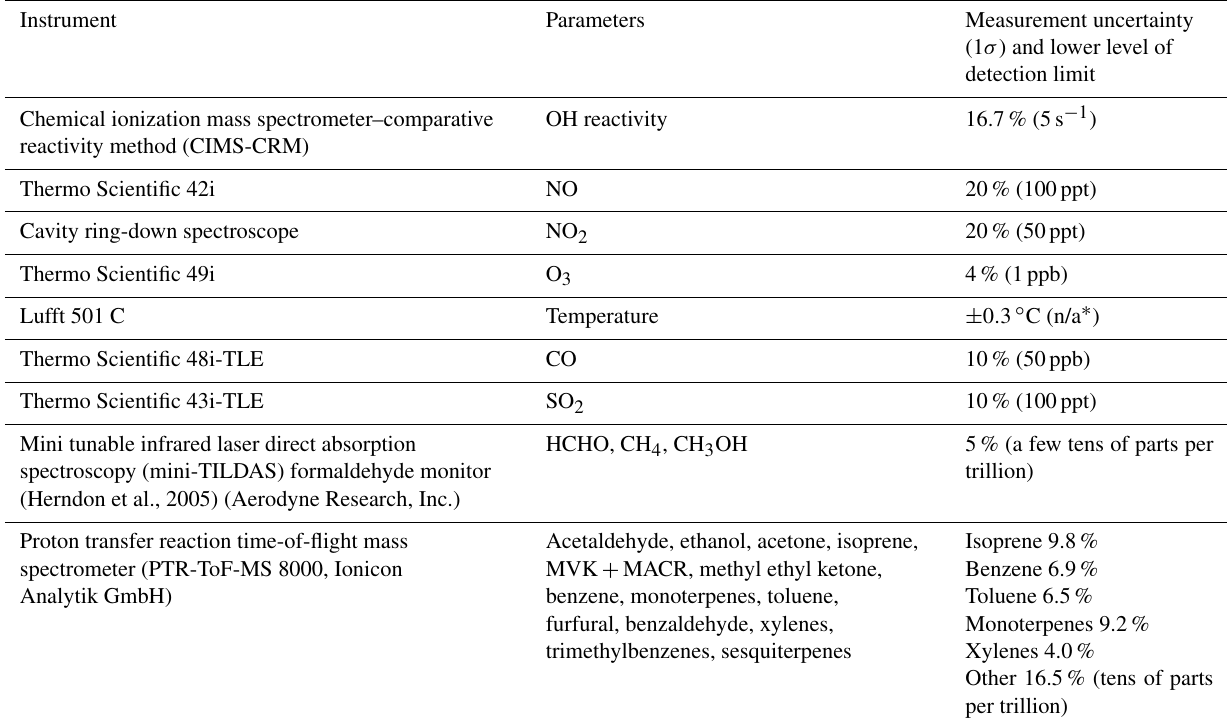
Table 1. Description of instrument and measured